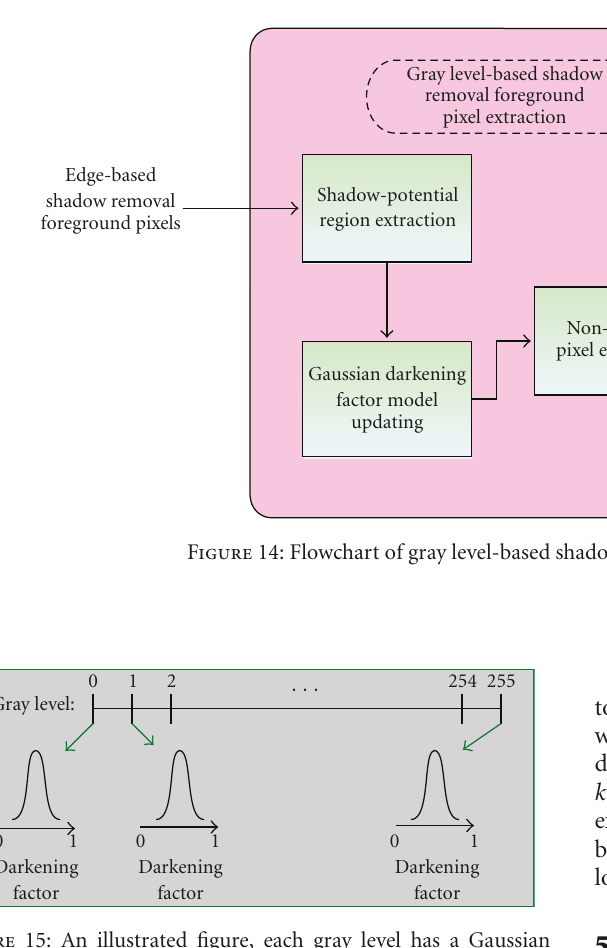
Figure 15: An illustrated figure, each gray level has a Gaussian